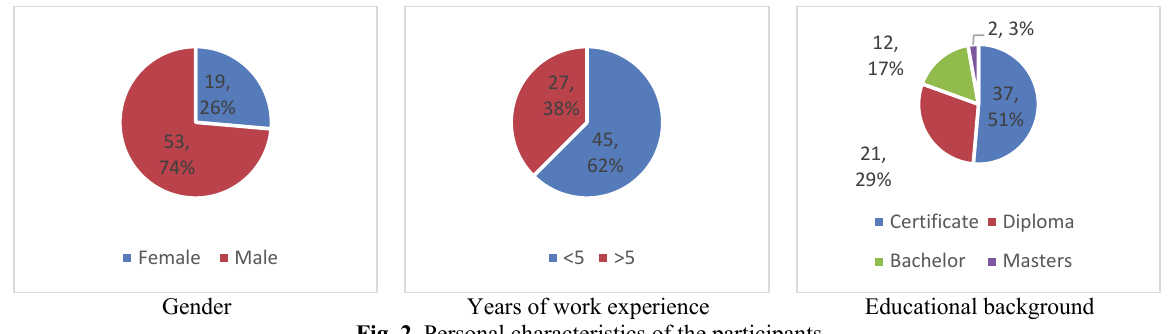
Fig. 2. Personal characteristics of the